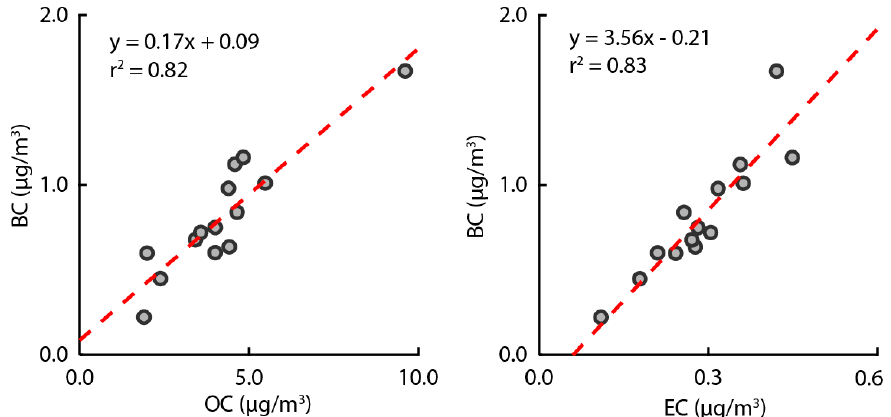
Figure 5. Ratios of BC, EC, and OC according to the analysis of PM 2.5 .